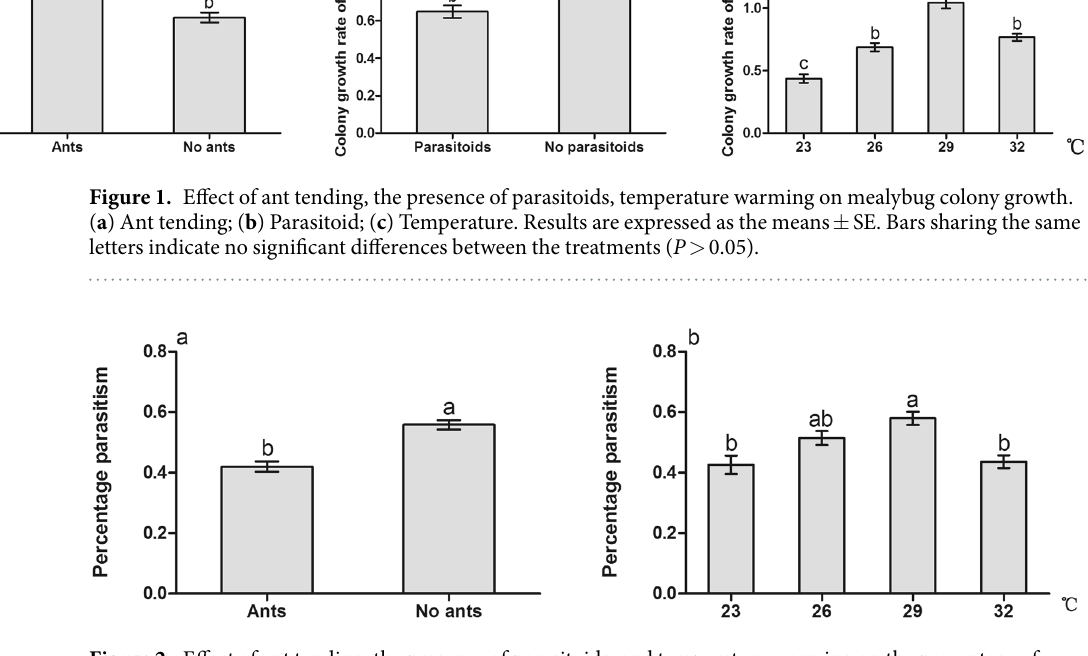
Figure 2. Effect of ant tending, the presence of parasitoids, and temperature warming on the percentage of parasitism. ( a ) Ant tending; ( b ) Temperature. Results are expressed as the means ± SE. Bars sharing the same letters indicate no significant differences between the treatments ( P >